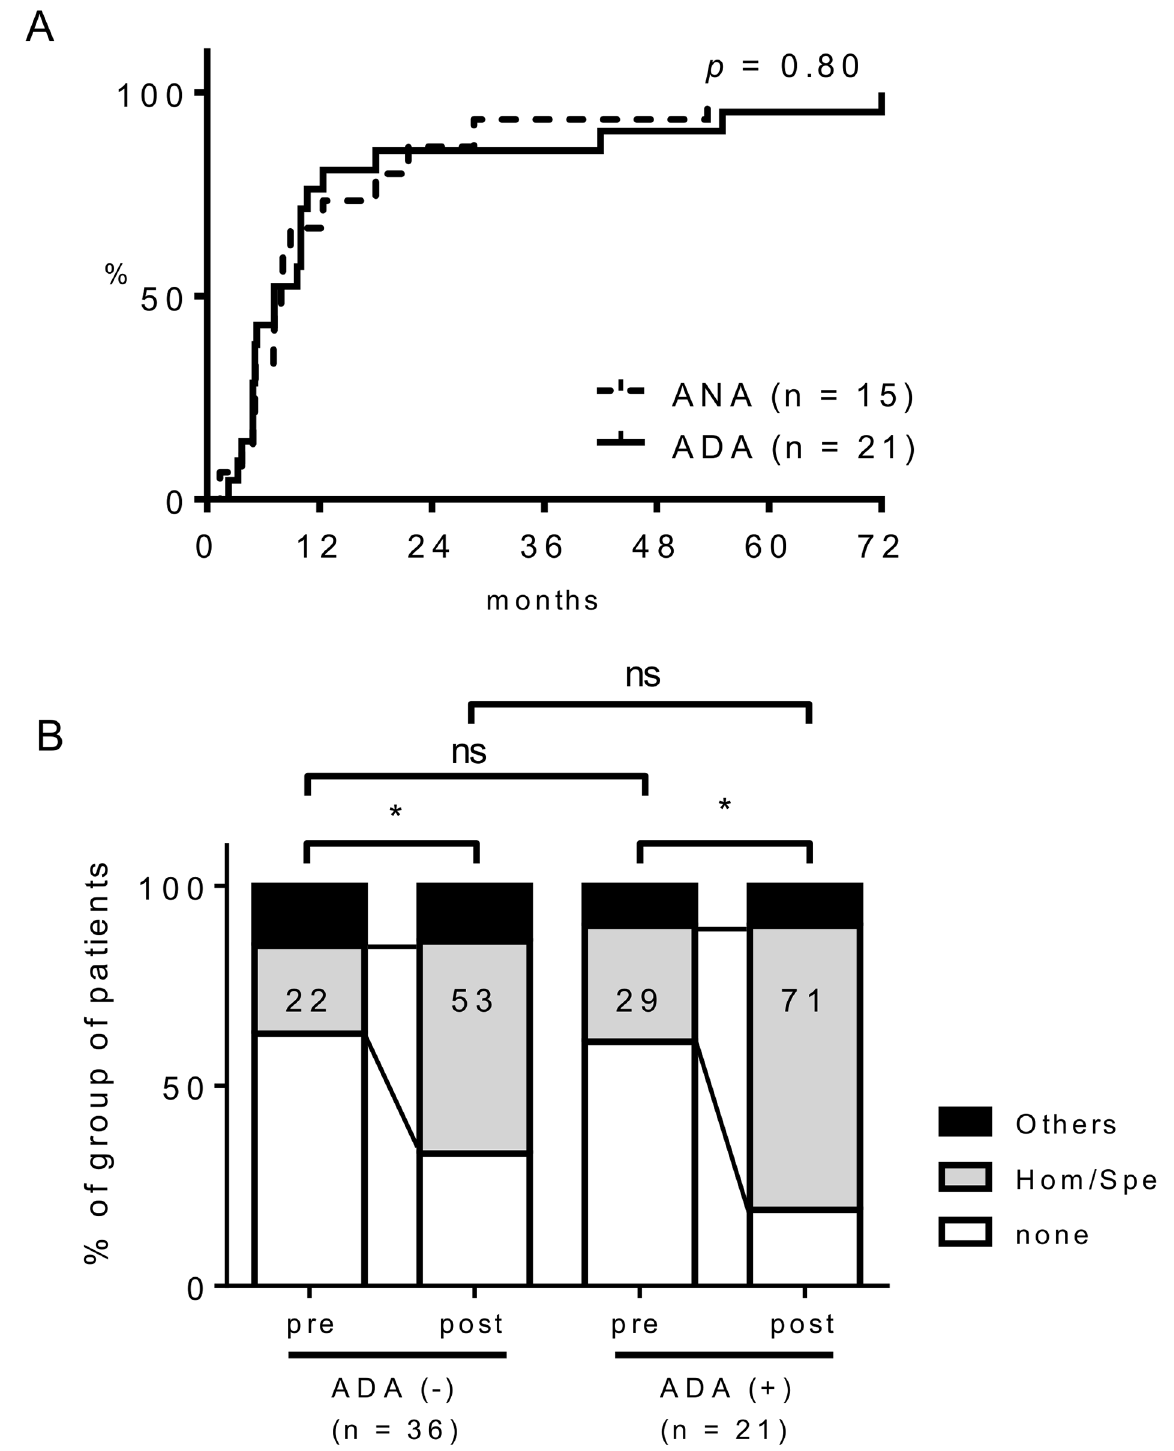
Fig 2. The association between ADA and ANA. (A) The proportion of ADA (n = 21) and ANA ( (cid:1) ×160, n = 15) positive patients at different time points after IFX treatment in the ADA-positive group. A log-rank test was used for comparison between ADA and ANA curves. (B) Changes in the ANA staining pattern before (pre) and after (post) IFX. Numbers in bar graphs indicate percentages of patients with Hom/Spe pattern of FANA. None, ANA titer was (cid:3) ×40; Hom/Spe, homogenous/speckled. The chi-square test was used for comparison. * p = 0.037 (ADA-negative group) and p = 0.032 (ADA-positive group), ns: not